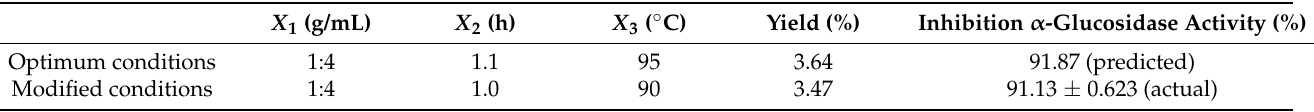
Table 4. Predicted and experimental values of the responses at optimum and modified conditions.